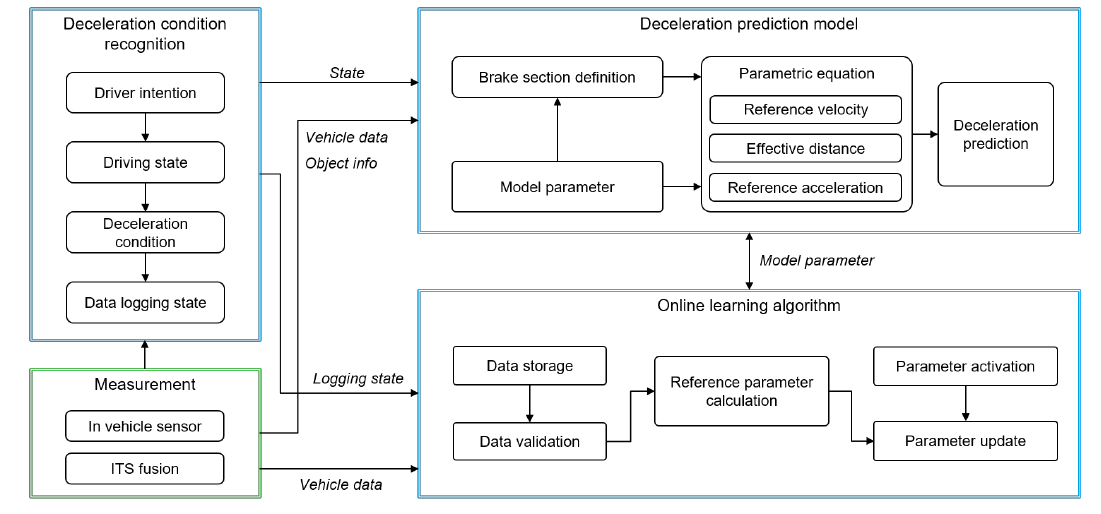
Figure 4. Overall algorithm structure.